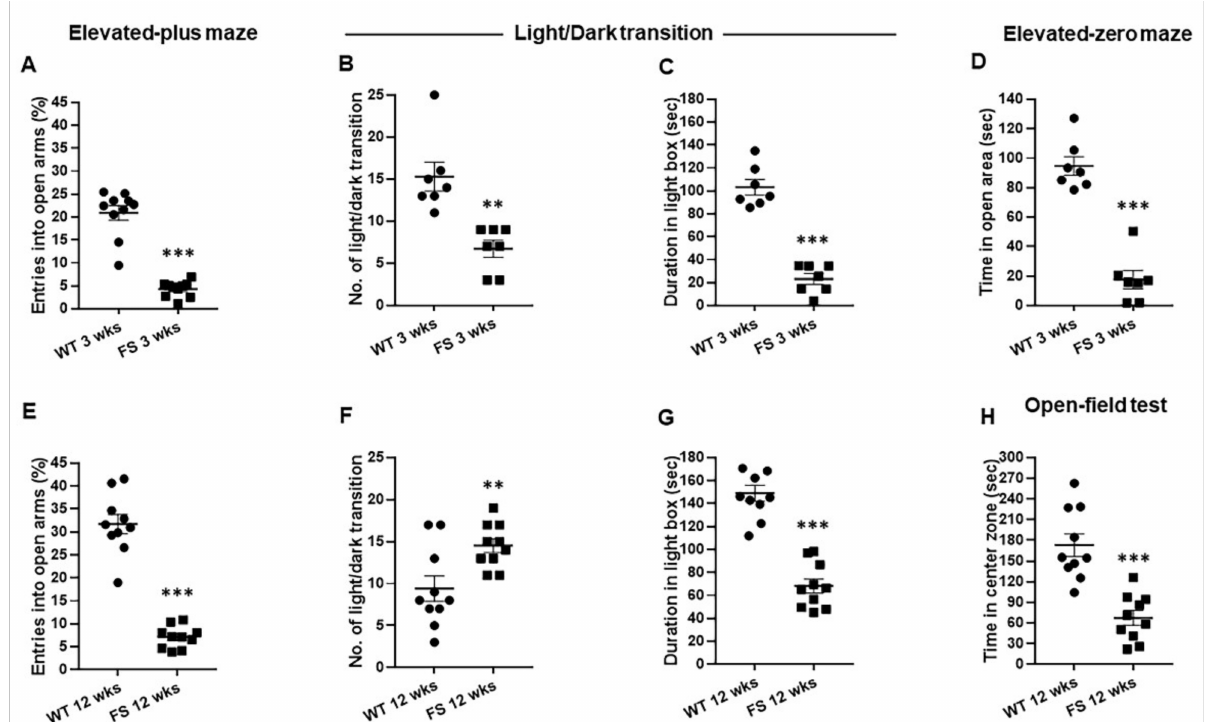
Figure 1. Increased anxiogenic behaviors in FS rats. Anxiety levels of FS 3 weeks rats were signifi- cantly enhanced in comparison with those in wild-type rats at 3 weeks. Percentage of entries into open arms in the elevated plus maze test ( A ). Number of light–dark transitions ( B ). Duration in the light box of the light–dark transition apparatus ( C ). Time in the light compartment in the zero maze test ( D ). Anxiety levels of FS 12 weeks rats were increased in comparison with those of wild-type rats at 12 weeks. Percentage of entries into the open arms in the elevated plus maze test ( E ). Light–dark transition number ( F ). Duration in the light box of the light–dark transition apparatus ( G ). Time in the central sector of the open field ( H ). Data are presented as means ± standard errors of the mean. ** p < 0.01, *** p < 0.001, two-tailed t -test (WT 3 weeks, n = 10; FS 3 weeks, n = 10; WT 12 weeks, n =